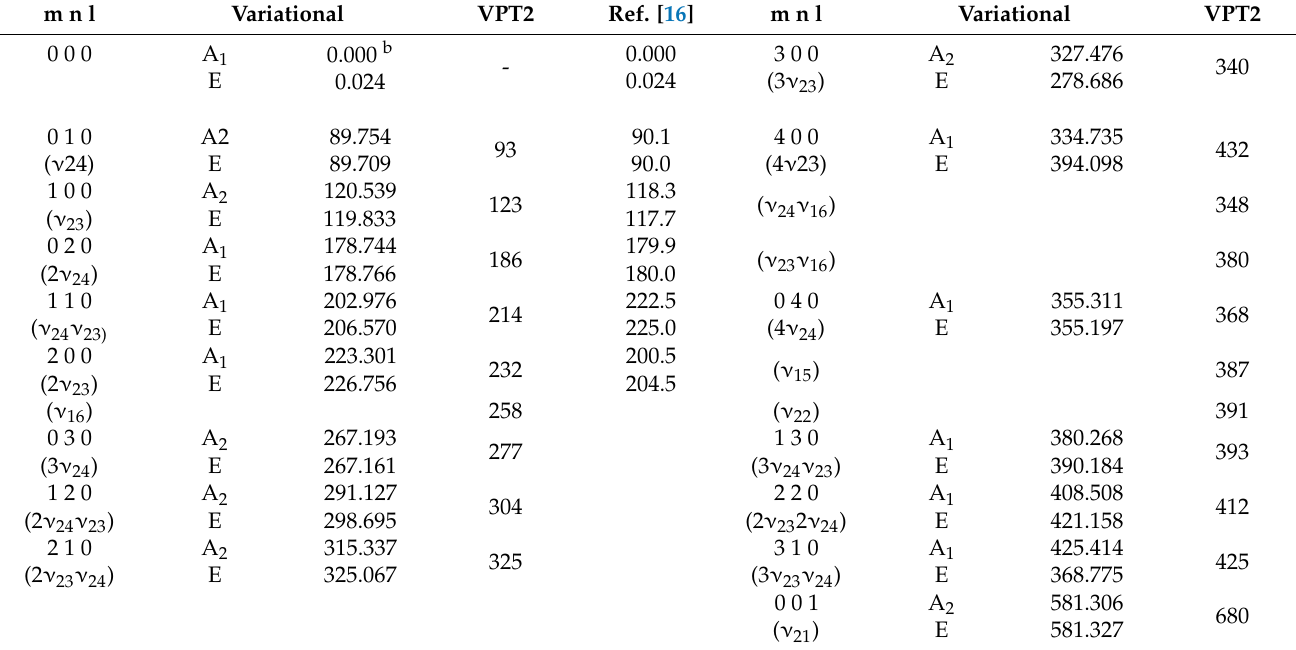
Table 6. Low-lying torsional energy levels (in cm − 1 ) of pyruvic acid computed variationally and/or with VPT2 a . The m, n, and l quanta corresponds to the θ 1, θ 2 , and α coordinates. m n